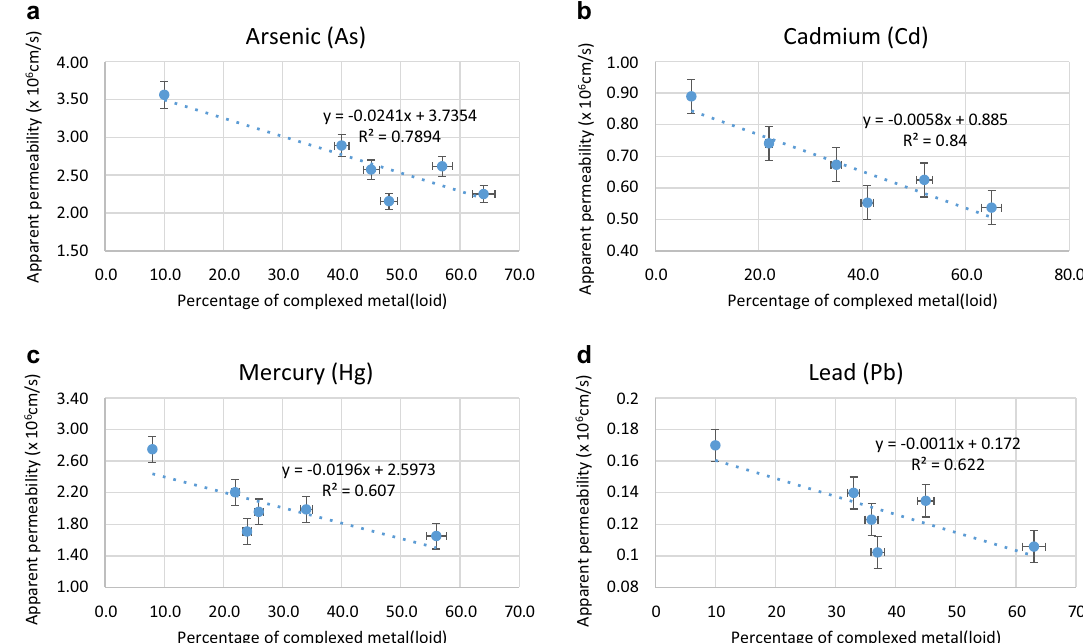
Figure 6. Relationships between percentage complexed metals and intestinal permeability of As, Cd, Hg and